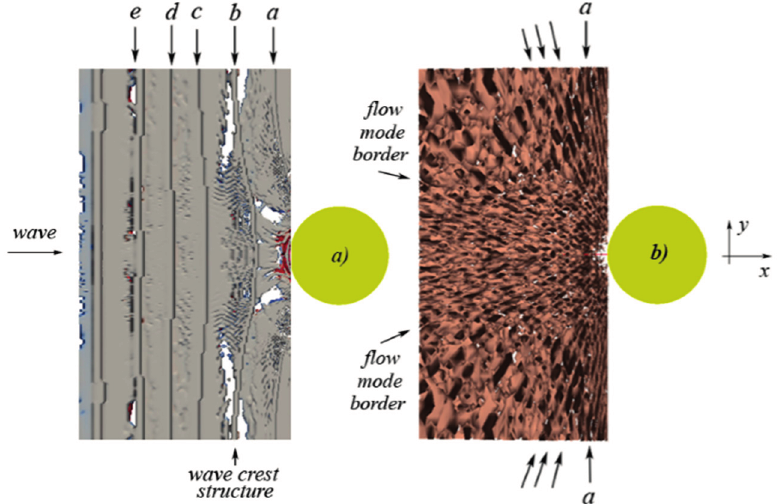
Figure 24. Flow-field representation at 0.000 T = ( T is wave period), top view (free-surface level): ( a ) flow-structures (colored with spanwise vorticity); ( b ) surfaces of constant x- velocity from reconstruction based on the three most energetic KL modes.